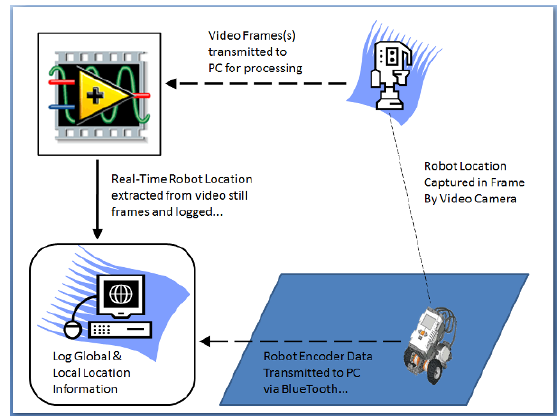
the wheels. The forward direction for the robot is in the direction of travel, as shown in Fig. 1.